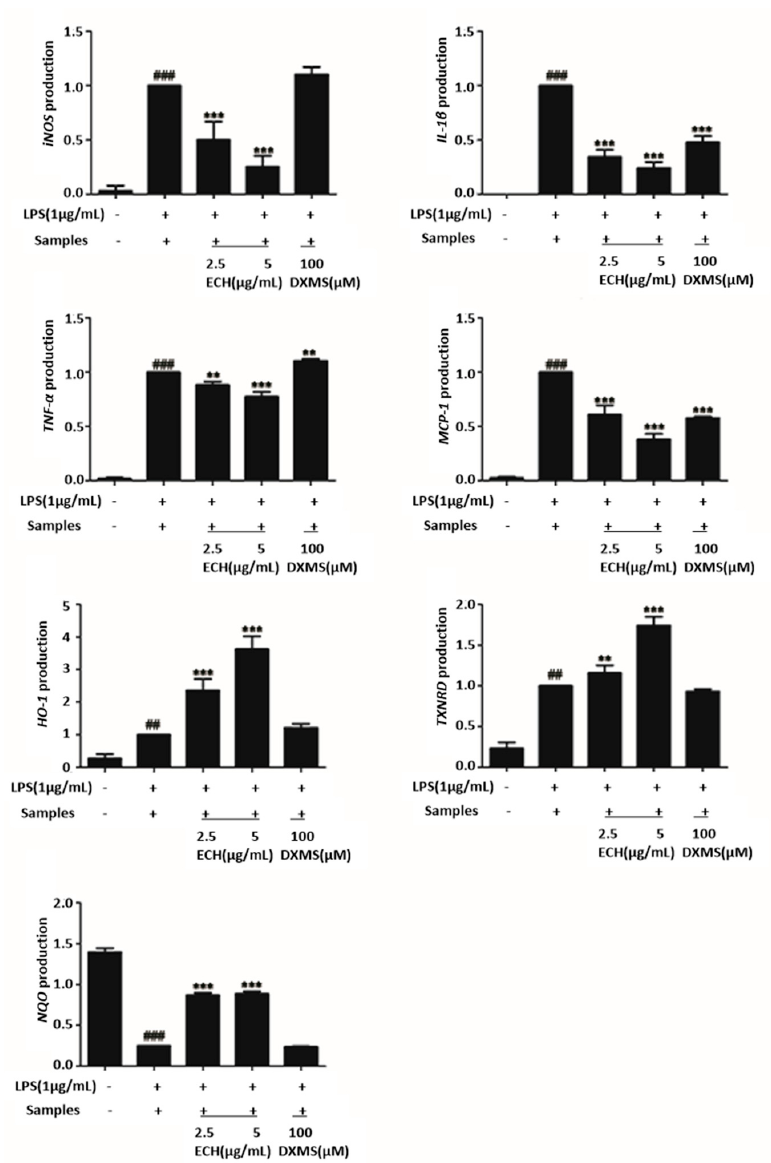
Figure 3. Effects of ECH on the expressions of antioxidant and inflammatory genes in LPS stimulated RAW 264.7 cells. RAW 264.7 cells were pretreated with/without indicated concentrations of ECH or dexamethasone (100 μ g/mL, positive control) for 1 h then stimulated with LPS (1 μ g/mL) for 6 h. mRNA expression in RAW 264.7 cells were measured using RT ‐ qPCR. ** ( p < 0.01) and *** ( p < 0.001) indicates significant di ff erence compared with the LPS group. ## ( p < 0.01) and ### ( p < 0.001), compared with the normal control